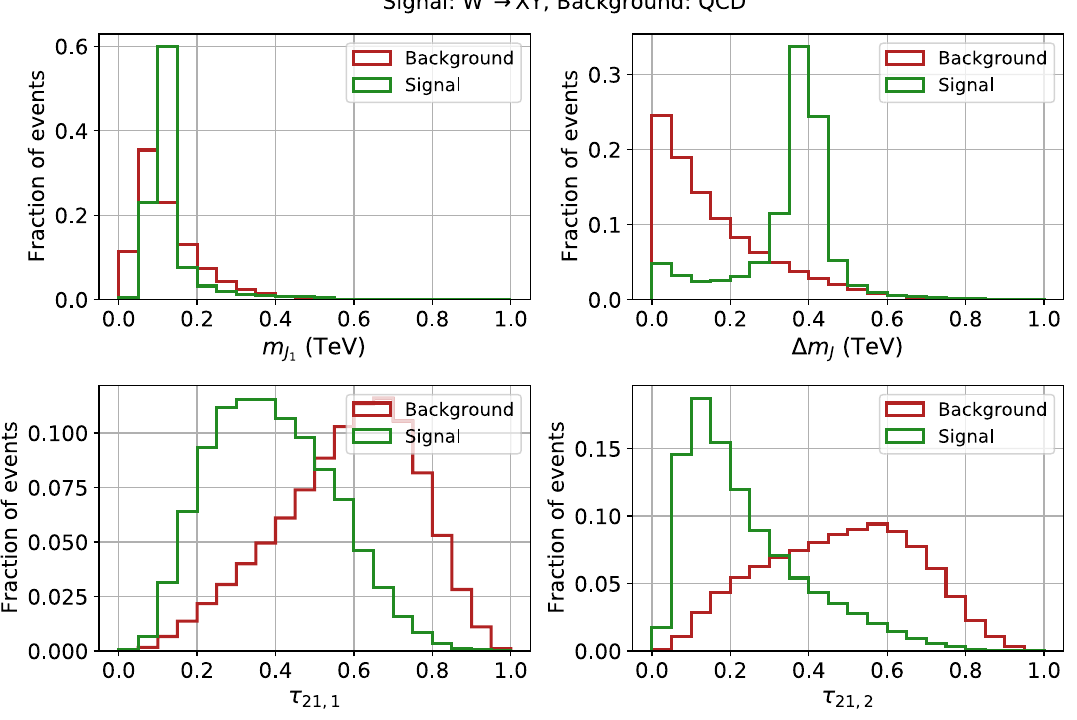
Fig. 7 Distribution of the four features that characterize the dijet events.Signalcorrespondstoanewresonance W (cid:2) → XY bothdecaying to two large-radius jets with two-prong substructure, and background to QCD dijet processes. The signal distributions on the top panels are